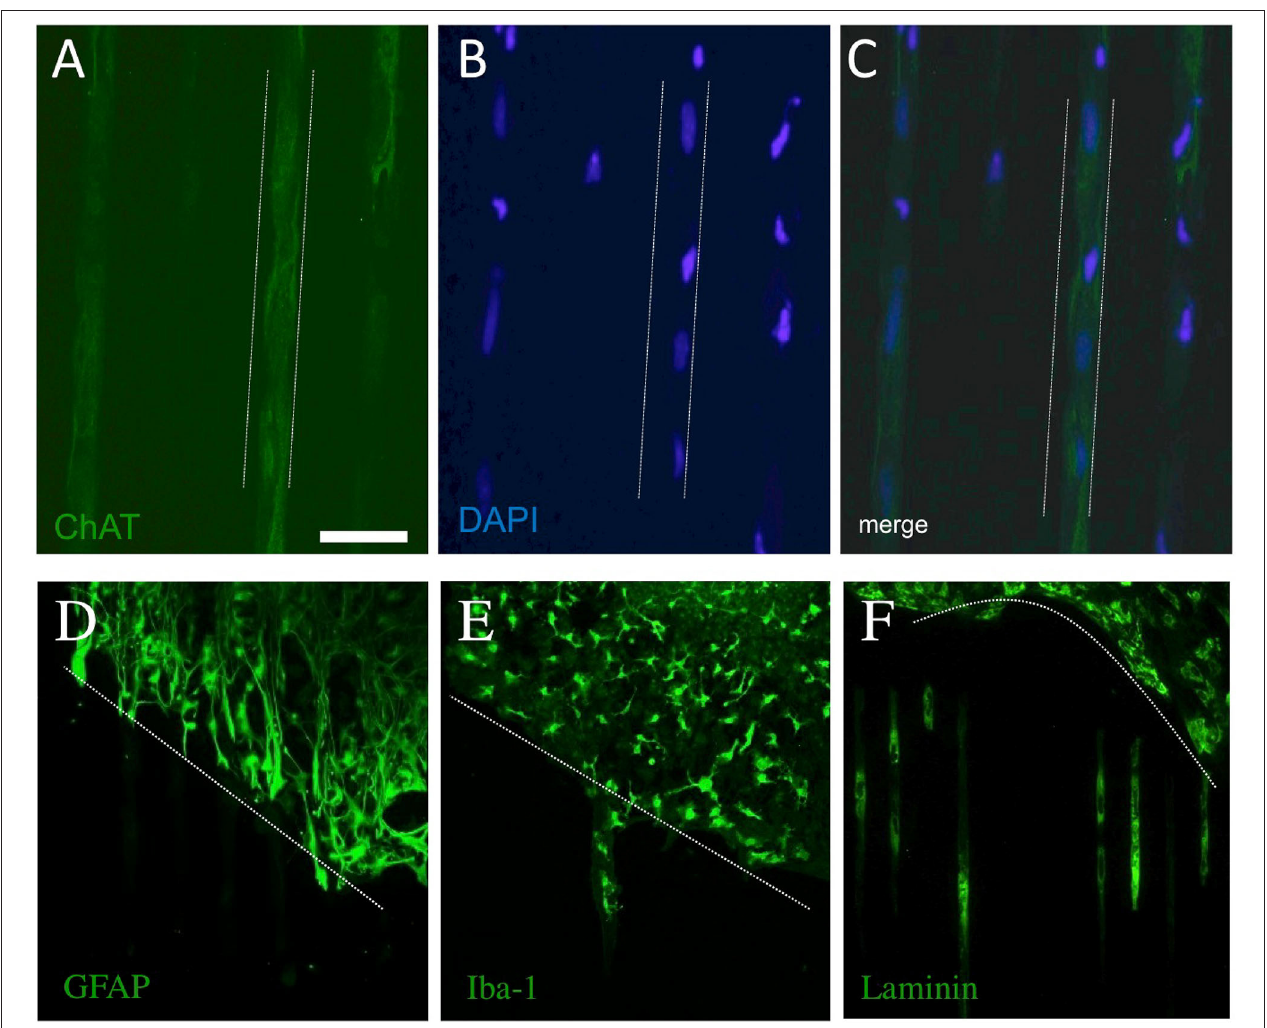
FIGURE 7 | Migration of cholinergic neurons (choline acetyltransferase, ChAT + ), astrocytes (glial fibrillary acidic protein, GFAP + ), microglia (Iba-1 + ), and endothelial cells (laminin + ) along the collagen µ CP. The dotted lines in (A–C) indicate the µ CP lanes and in (D–F) the borders of the slices are shown by a dotted line. The ChAT + processes grew along the µ CP(NGF) lanes (A) , and blue fluorescent DAPI + nuclei are seen in these processes (B,C) , suggesting the migration of cholinergic neurons. Glial fibrillary acidic protein was highly expressed within the slices, but no processes were seen outside (D) . Iba-1 + (E) as well as laminin + (F) cells migrated along the collagen µ CP. Twenty brain slices were prepared from five animals. Scale bar in A = 100 µ m (A–C) , 200 µ m (D–F)